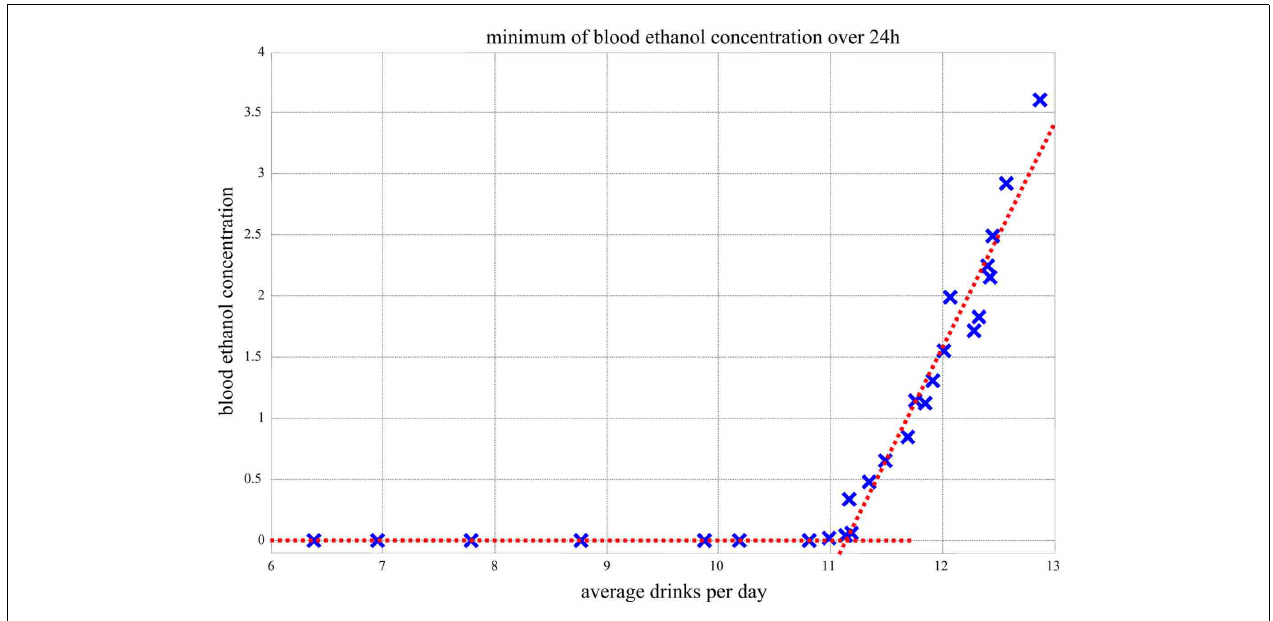
alcohol level on average number of drinks per day depicted in Figure 12